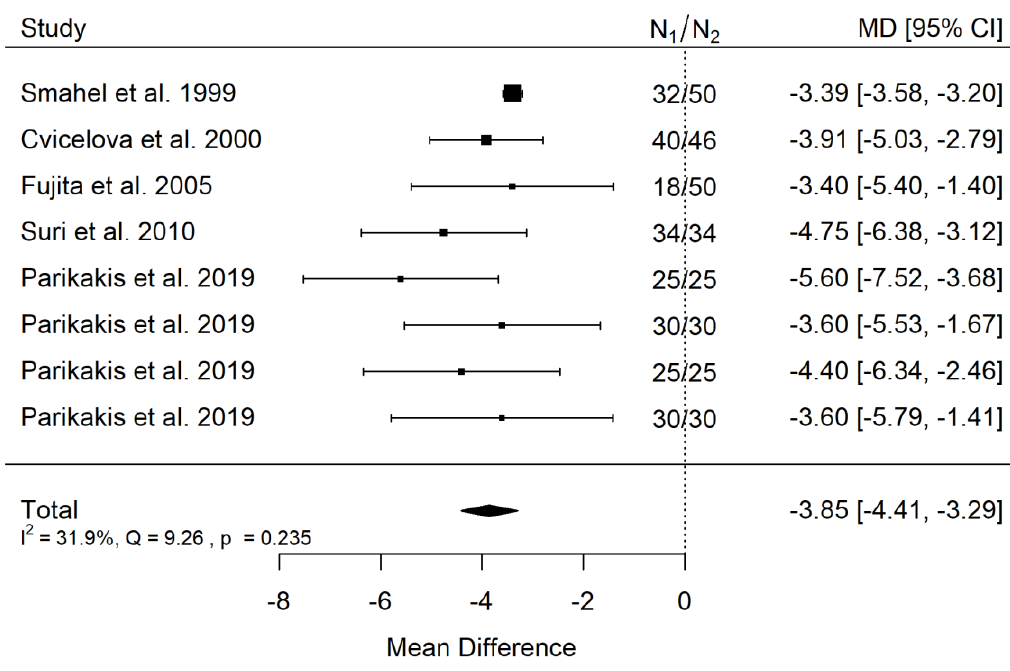
Figure 10. Forest plot of SNA values for the comparison of patients with cleft palate only treated surgically and orthodontically vs. non-cleft healthy population [19,22,29,32,33].